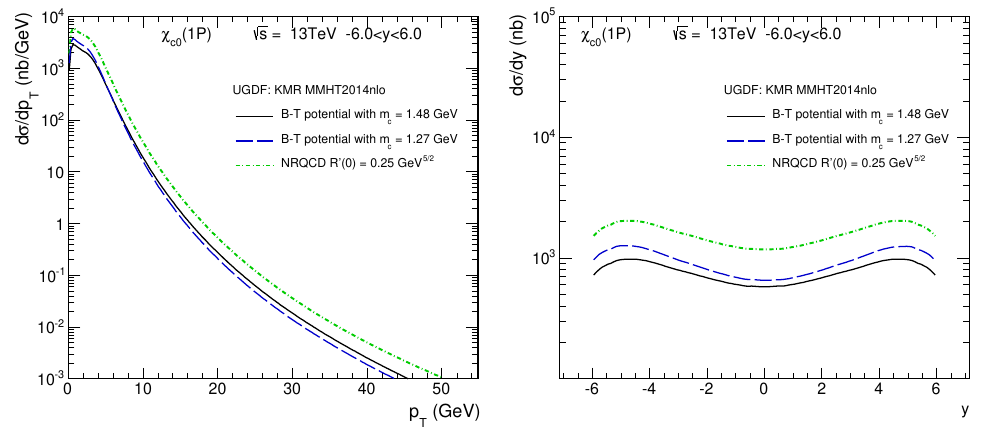
Figure 10 . Comparison of p T distributions of (cid:31) c 0 for our full model (solid line | with m c = 1 : 48 GeV, dashed line | with m c = 1 : 27 GeV) with the NRQCD result (see eq. (3.21)) (dash-dotted line). Here the B-T potential and the KMR UGDF were used. In the NRQCD matrix element we applied R 0 (0) = 0 : 25 GeV 5 = 2 (the extracted value from the experimental radiative decay width, see table 6).